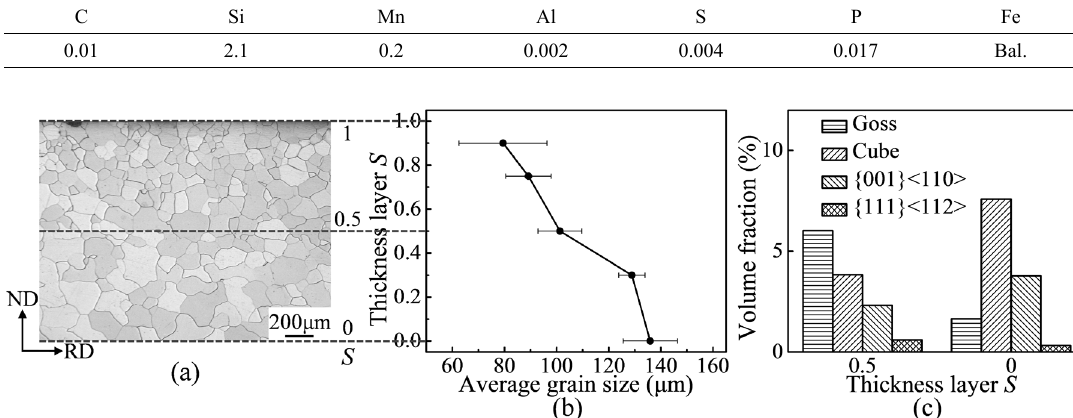
Table 1. Chemical composition (in wt.%) of the investigated alloy.